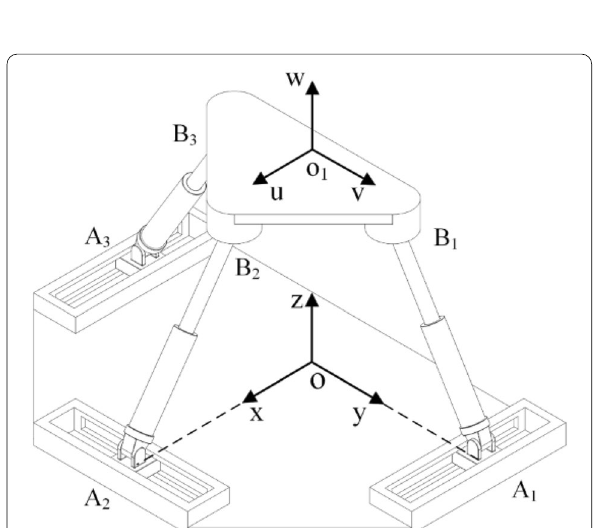
Figure 12 Actuator of the 3-PRPS PM